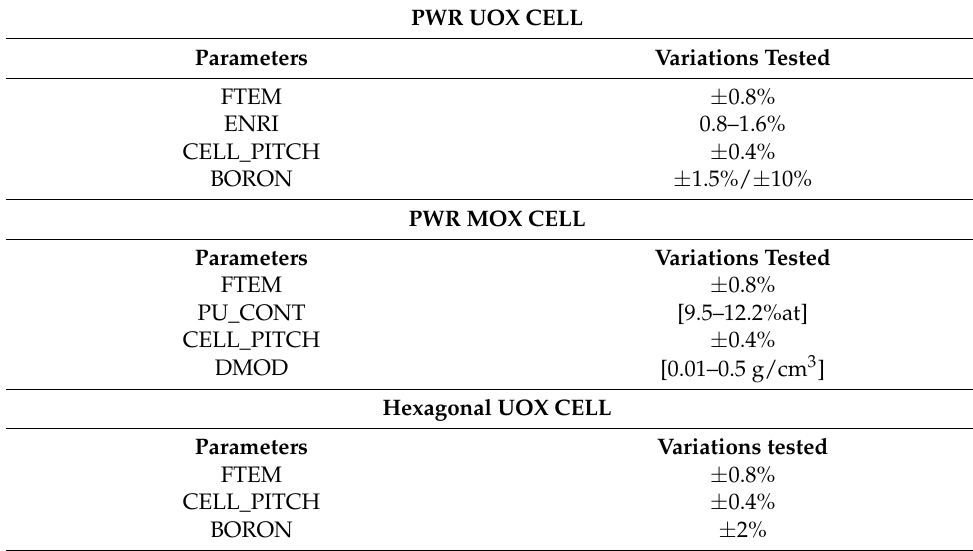
Table 6. Cell Cases: parameters and distributions used for the